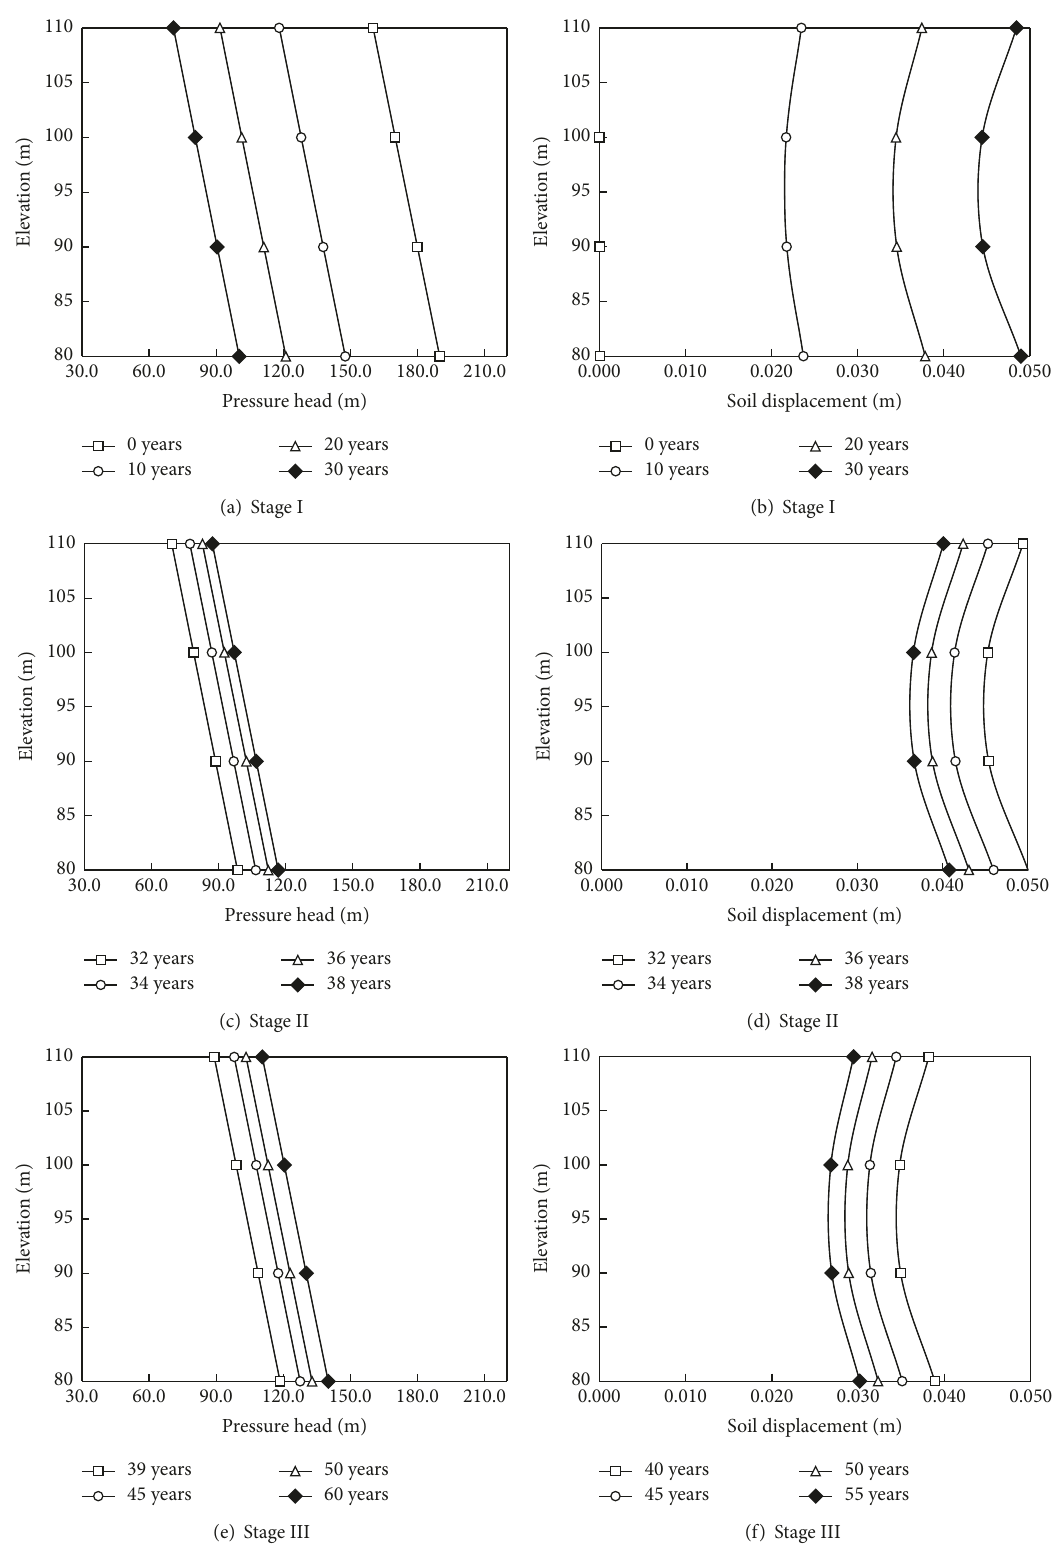
Figure 6: Distributions of pressure head and soil displacement in confined aquifer II during different